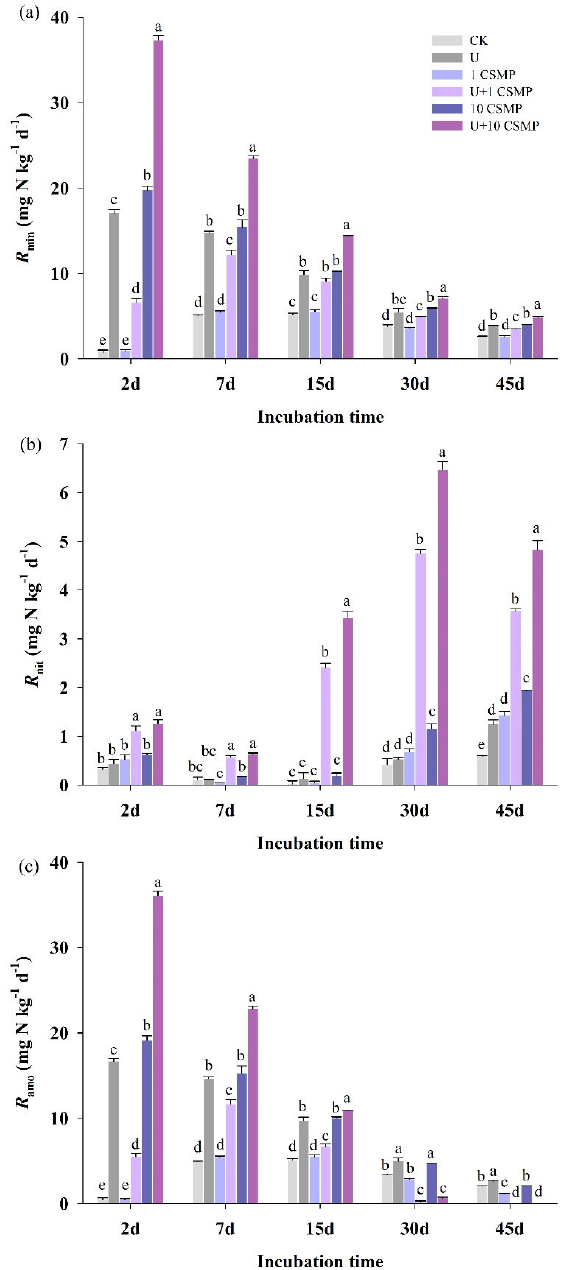
Figure 5. Soil net nitrogen mineralization rate ( R min ) ( a ), soil net nitrification rate ( R nit ) ( b ) and soil net annonification rate ( R amo ) ( c ) during the incubation period for different treatments. CK, no mineral amendments or urea; U, urea at 60 mg N kg − 1 soil; 1 CSMP, 1 g CSMP kg − 1 soil; U+1 CSMP, urea at 60 mg N kg − 1 + 1 g CSMP kg − 1 soil; 10 CSMP, 10 g CSMP kg − 1 soil; U+10 CSMP, 60 mg N kg − 1 + 10 g CSMP kg − 1 soil. Error bars represent standard error of the mean (n = 3). Different lowercases indicate significant differences among treatments ( p < 0.05).